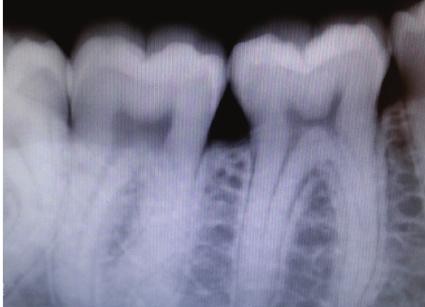
Figure 2: Elastic band was easily removed using forceps.